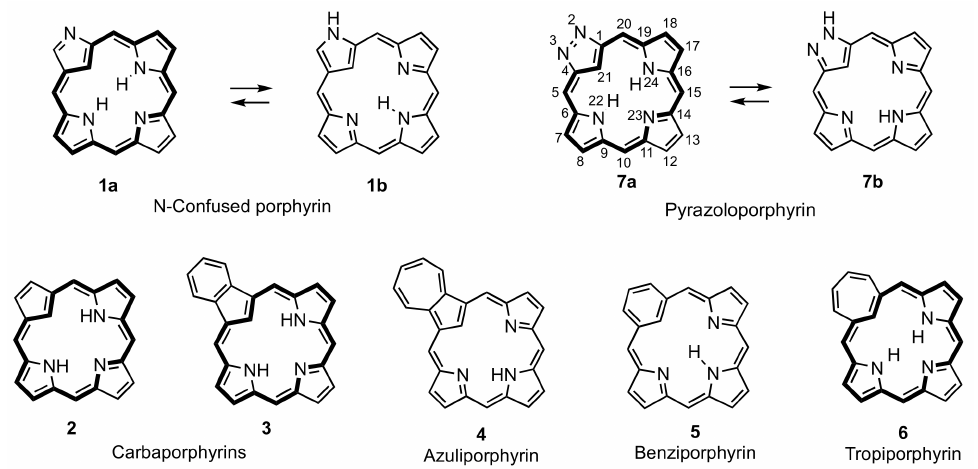
Figure 1. Selected carbaporphyrinoid